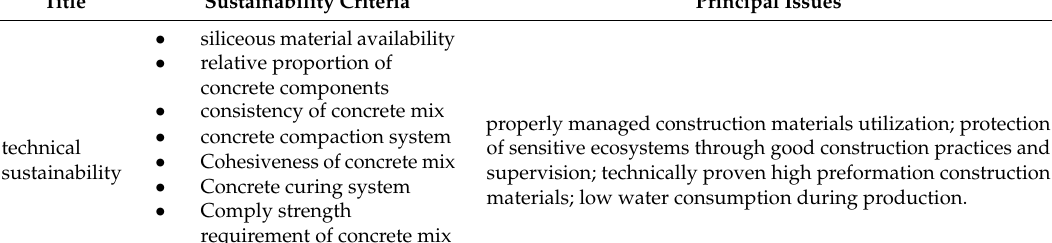
Figure 1. Fuzzy Technique for Order of Preference by Similarity to Ideal Solution (fuzzy-TOPSIS) based framework for ranking of sustainable siliceous concrete material management. Table 1. Sustainable criteria along with sustainability indicators (sub-criteria) for selection of siliceous concrete materials and their principal